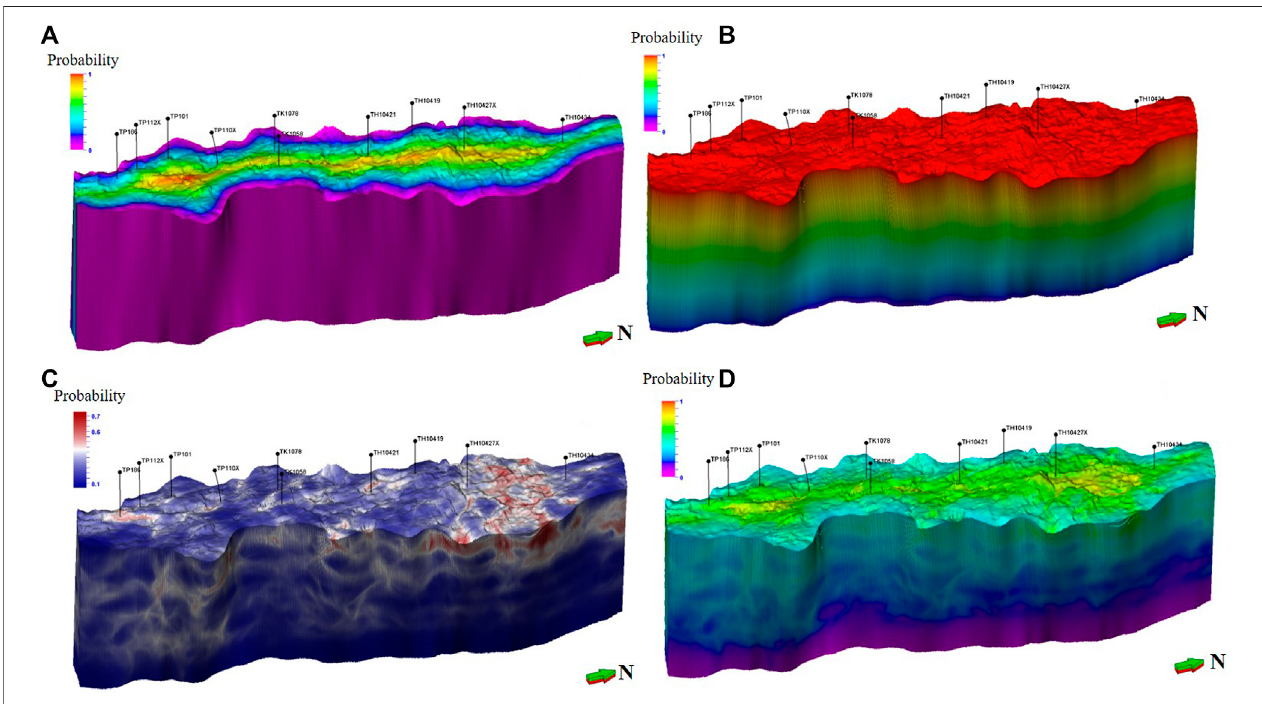
FIGURE 7 | Probabilistic models used for fault-controlled internal paleokarst elements modeling in the TP12CX units. (A) Fault-controlled lateral geological probabilitymodel; (B) Erosionsurface-controlled vertical geological probabilitymodel; (C) Seismic probability model; (D) Geo-seismic synthetic probability modelbased on linear